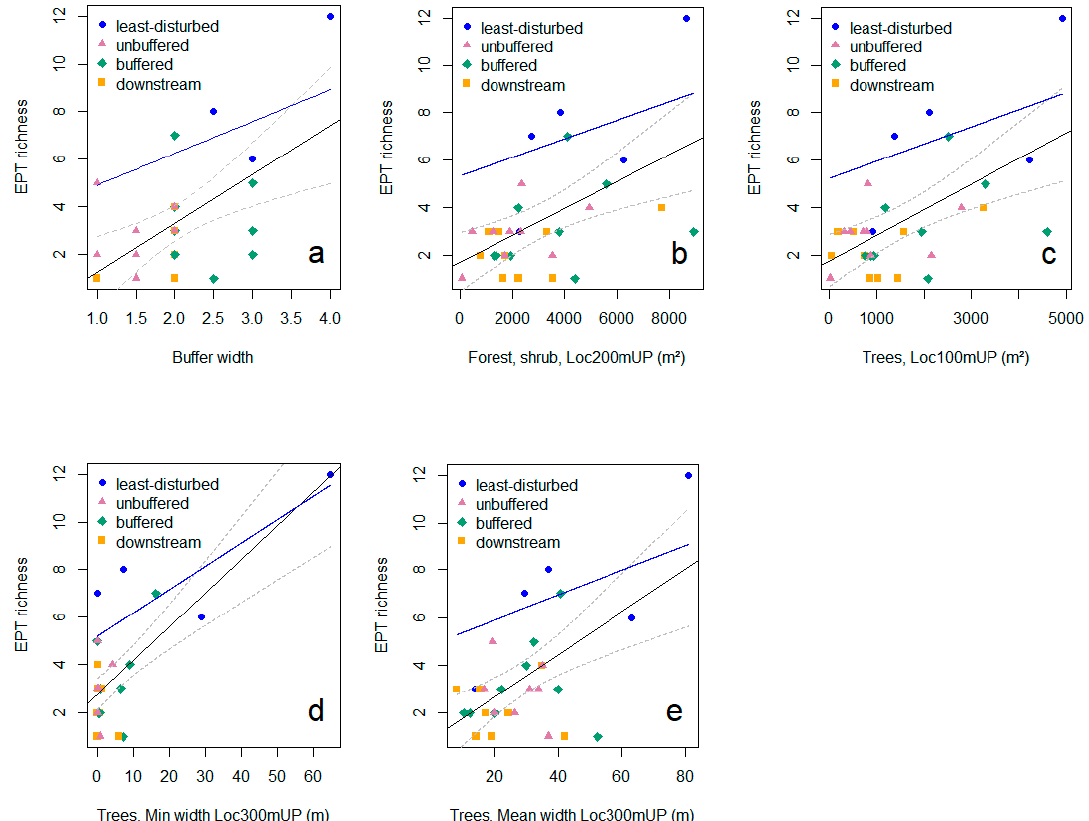
Figure 3. Mean EPT richness in relation to the quick assessment method, buffer width ( a ), and GIS methods, area of trees in spatial units Loc200mUP ( b ), Loc100mUP ( c ); minimum and mean width of trees in spatial unit Loc300mUP (( d , e ), respectively) are represented by grey lines. Grey dash lines are the confidence interval and the dots represents the sampling points. The blue line represents the mean EPT richness in relation to the respective riparian attribute at least-disturbed site type. The p -values are presented in Table S5.